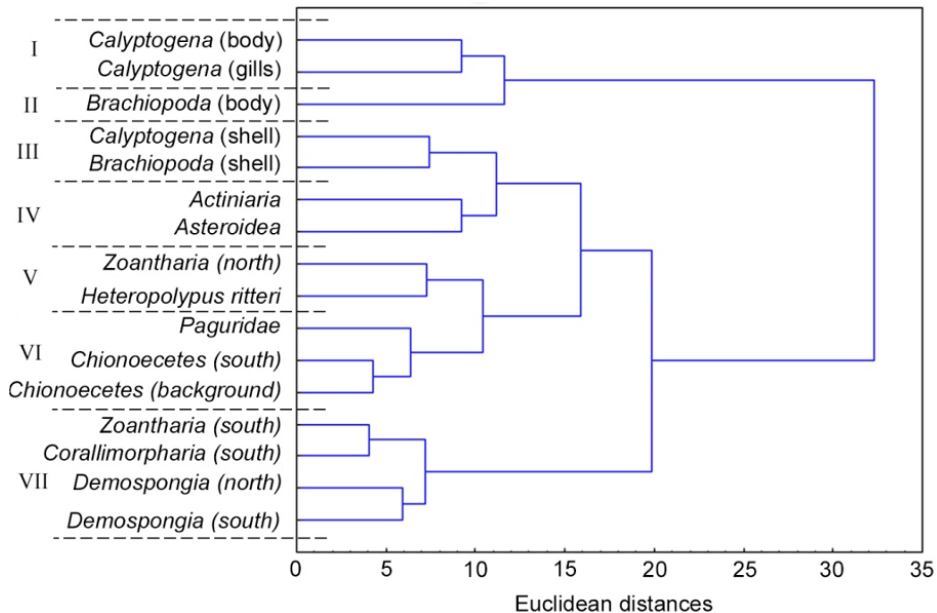
Figure 17. Dendrogram of relationship between trace element accumulation in different groups of bottom organisms inhabiting the Piip Volcano